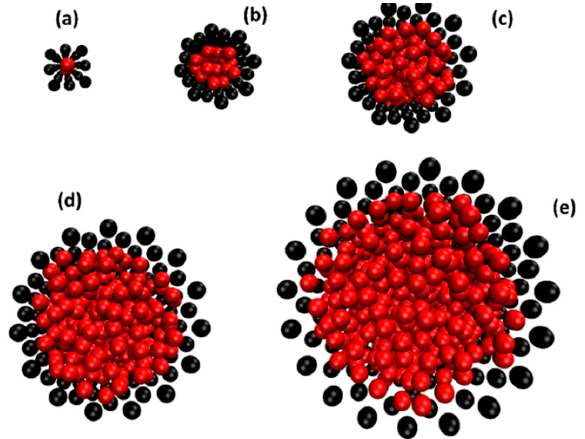
Figure 1. A snapshot at equilibrium (top view) of water beads inside an (8, 8) ( a ); (15, 15) ( b ); (22, 22) ( c ); (30, 30) ( d ); and a (37, 37) ( e ) SWCNT at 298 K. The CNT and water are shown in black and red beads, respectively.